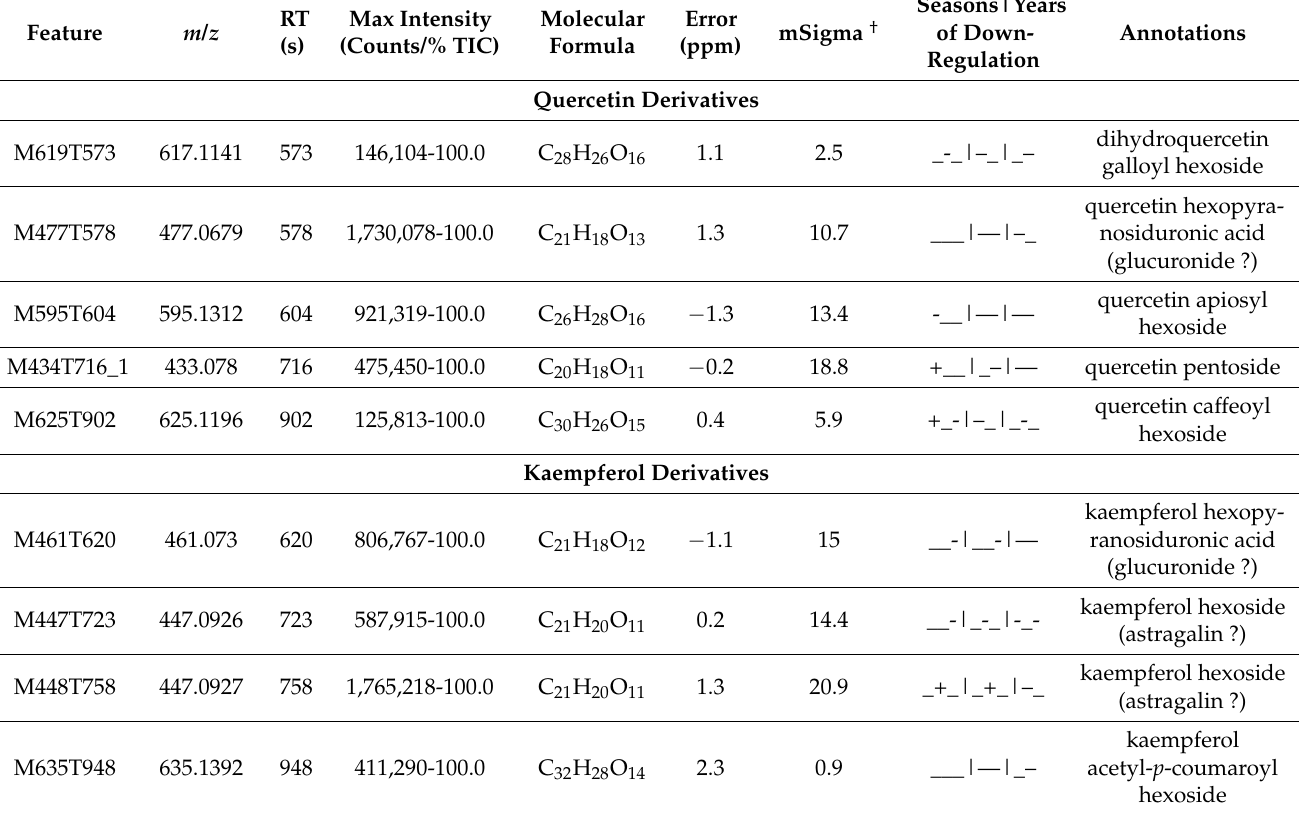
Table 2. Examples of downregulated drought biomarkers and their annotations, detected in tree leaves from AD plot, and highlighted through the construction of heatmaps and Venn